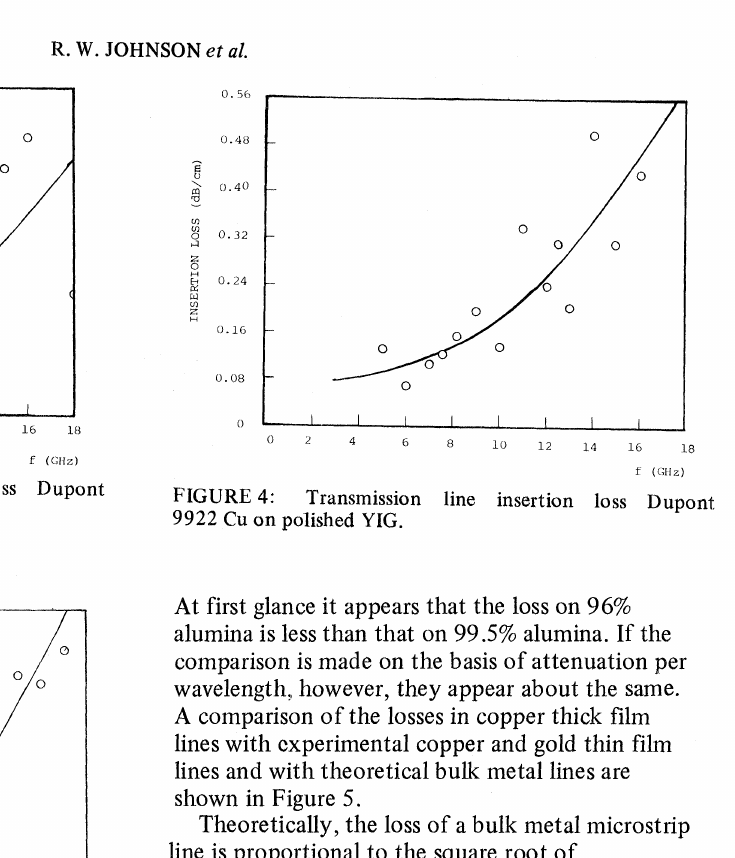
Transmission line insertion loss Dupont 9922 Cu on 99.5% alumina.